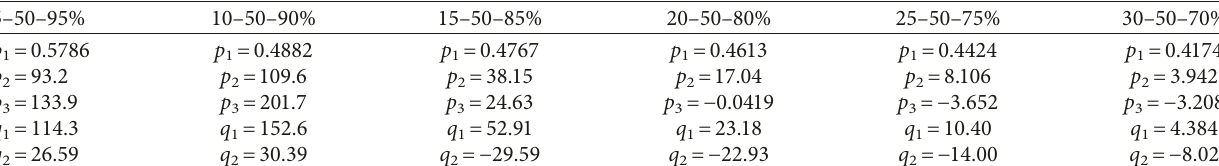
Figure 5: Data sets { Δ , α }, where Δ is defined in (32) and x � 5, 10, 15, 20, 25, and 30, and results of curve fitting for f Table 7: Parameters { p i , q i } of the rational function f 1 ( Δ ) for the different sets of symmetrical points.